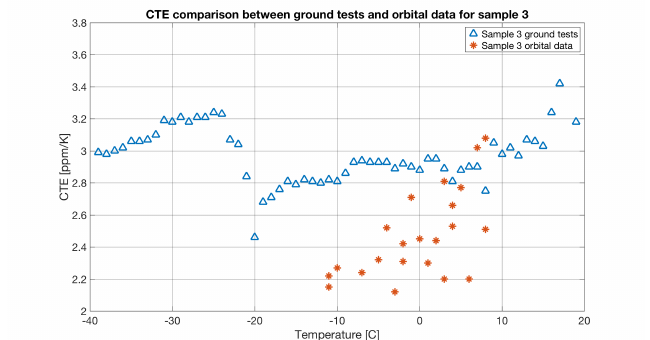
Figure 14. Material mission data obtained between December 2018 and January 2019. Estimated CTE from orbital data compared versus the ground test data for Sample